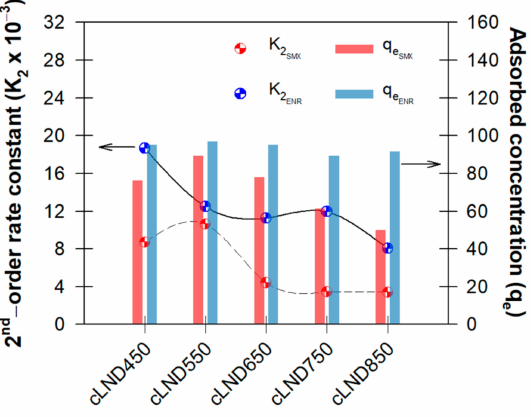
Figure 4. Changes in the pseudo-second-order reaction rates ( K 2 ) and adsorbed concentrations ( q e